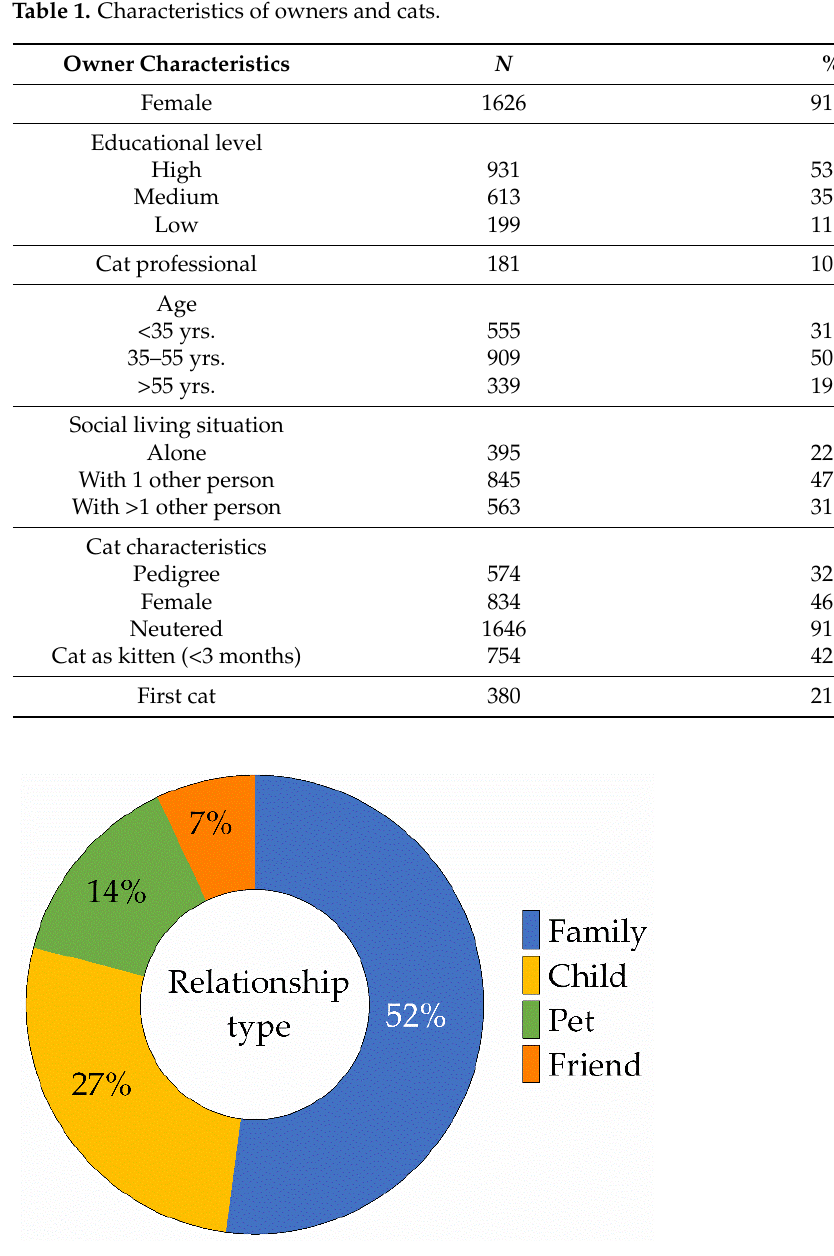
Figure 1. Percentage of participants for the different owner–cat relationship types ( n = 1803).